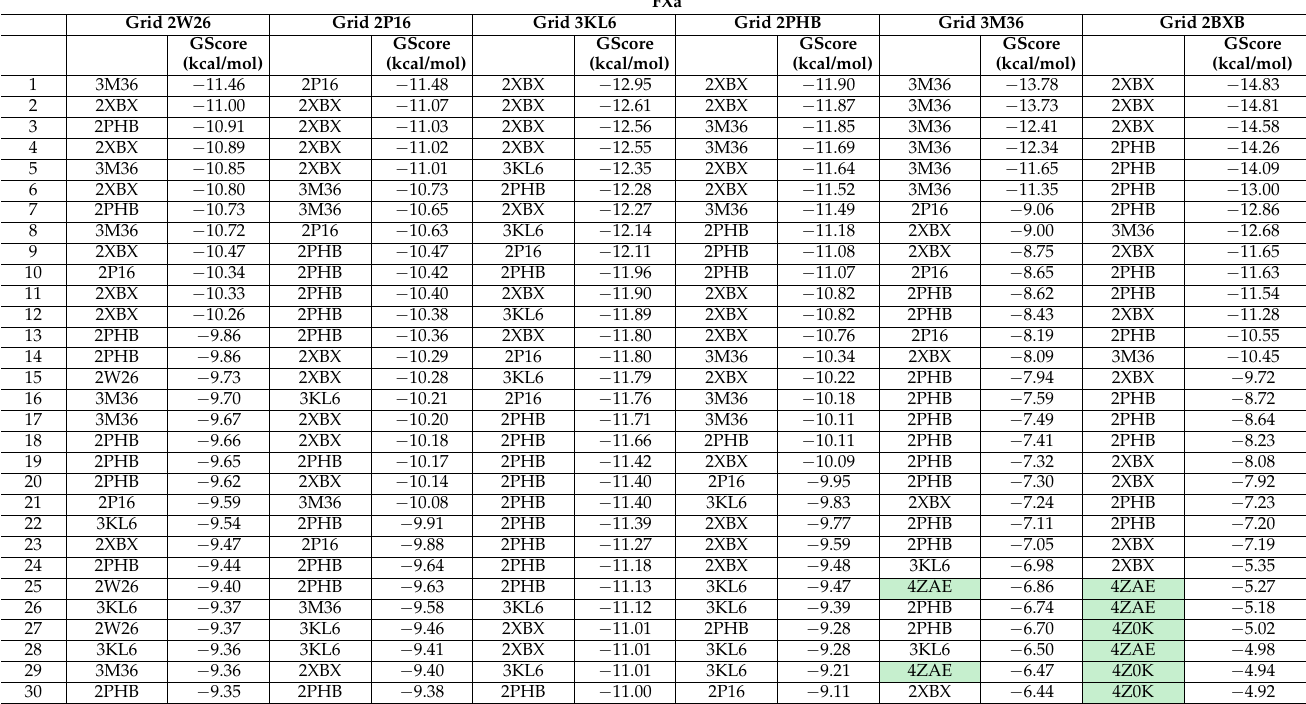
Table 3. Cross docking data with FXa grids. Green cells with green text represent the FIXa ligands and the red texts indicate moderate binding energy of the corresponding ligand. A longer form of this Table is provided in the Supplementary Information (Table